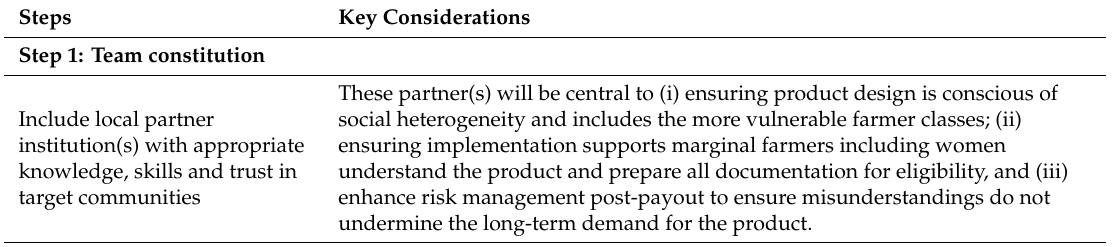
Table 4. A process-oriented framework to promote equity in weather index insurance (WII)